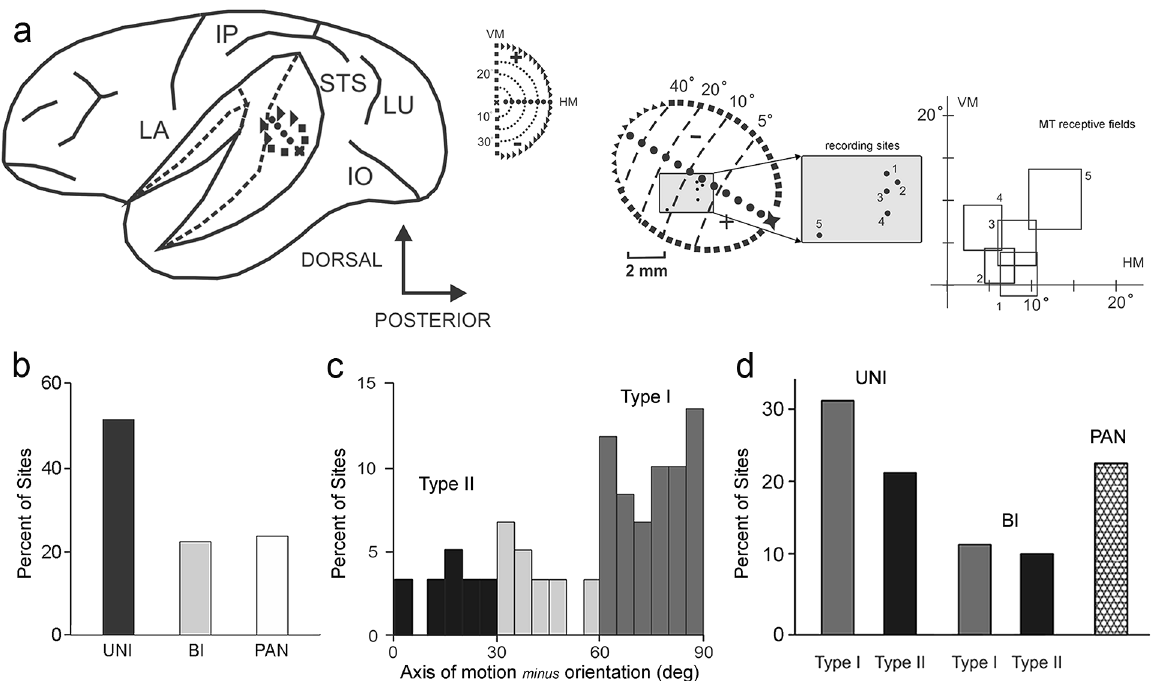
Figure 1. Placement of the planar electrode array and the distribution of neuronal response properties in area MT . (a) Left : Schematic representation of the left hemisphere of a capuchin monkey’s brain. The lateral and superior temporal sulci are shown open in order to evidence MT’s location and visual topography (see inset). Right : Five example recording sites in MT alongside their corresponding receptive fields. (b) Distribution of directional selectivity across three classes of sites: unidirectional (UNI), bidirectional (BI) and pan-directional (PAN). (c) Distribution of Type I and Type II sites. In order to compute the coaxiality of orientation vs. direction selectivity, we computed the difference between the preferred axis of motion and preferred orientation. (d) Distribution of cell types across 5 categories: Type I and Type II (each split for uni- and bidirectional selective sites), and PAN selective neurons. Abbreviations : IP, intraparietal sulcus; LA, lateral sulcus; STS, superior temporal sulcus; LU, lunate sulcus; IO, inferior occipital sulcus; VM, vertical meridian; HM, horizontal